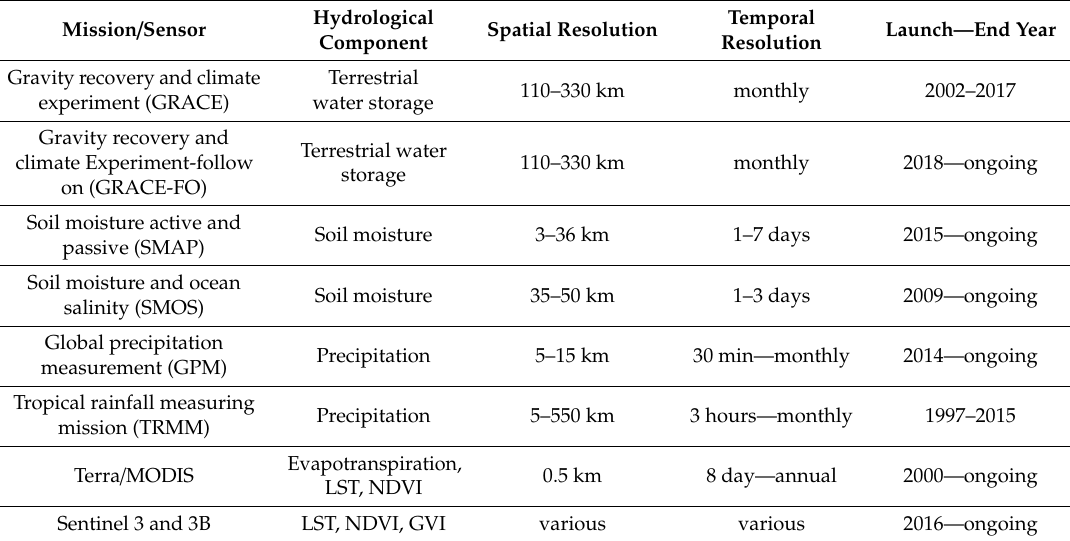
Table 2. Key remote-sensing missions for collection of hydrological